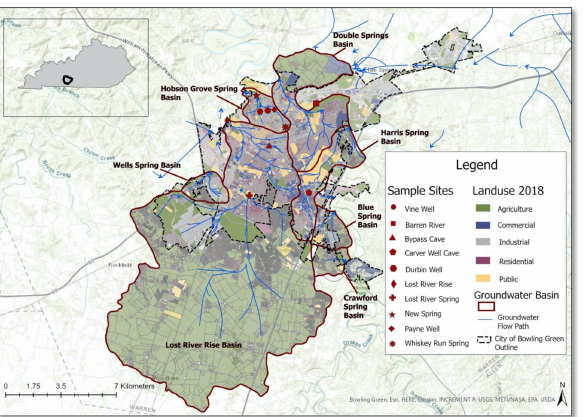
Figure 1. The sample sites, groundwater basins, groundwater flowpaths, and landuse for the Bowling Green, KY antibiotic resistance groundwater study